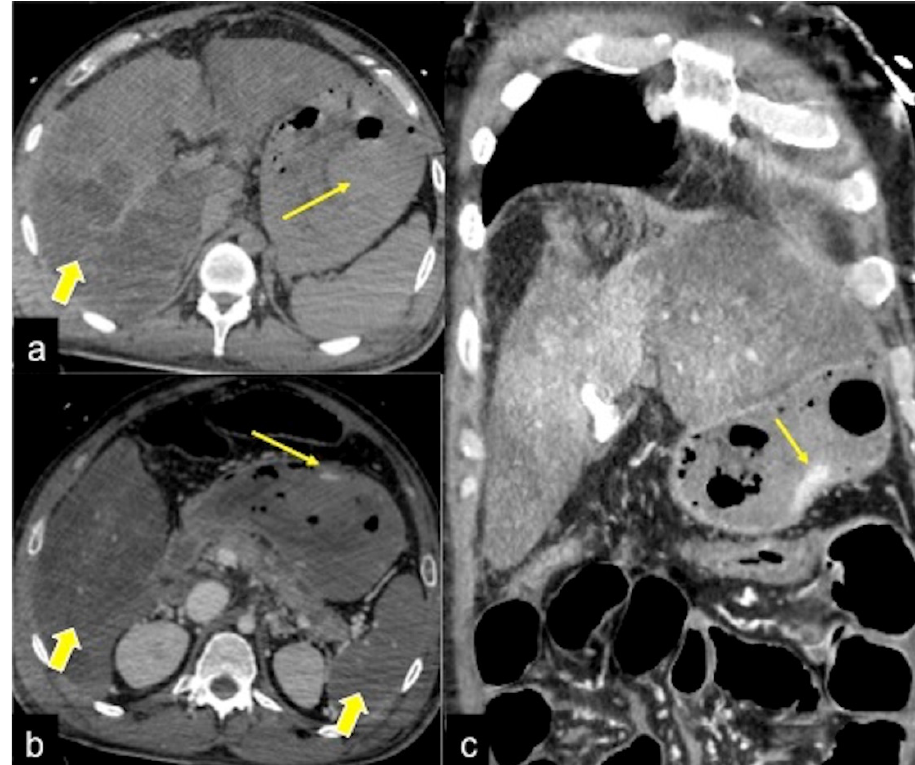
Figure 20. CTA multiphasic study of gastric bleeding in hypopefusive complex. The pre-contrast phase ( a ) shows a gastric endoluminal area of spontaneous hyperdensity (long arrow) as a sentinel clot associated with alteration of liver density in the right lobe (small arrow). In the arterial phase ( b ) an active haemorrhagic focus in the stomach (long arrow) associated with hypo perfusion of the liver and splenic parenchyma (large arrows) are detected as signs of hypotensive general status. In the venous phase ( c ) there is an enlargement of the haemorrhagic blush (long arrow) with inhomogeneous liver perfusion.